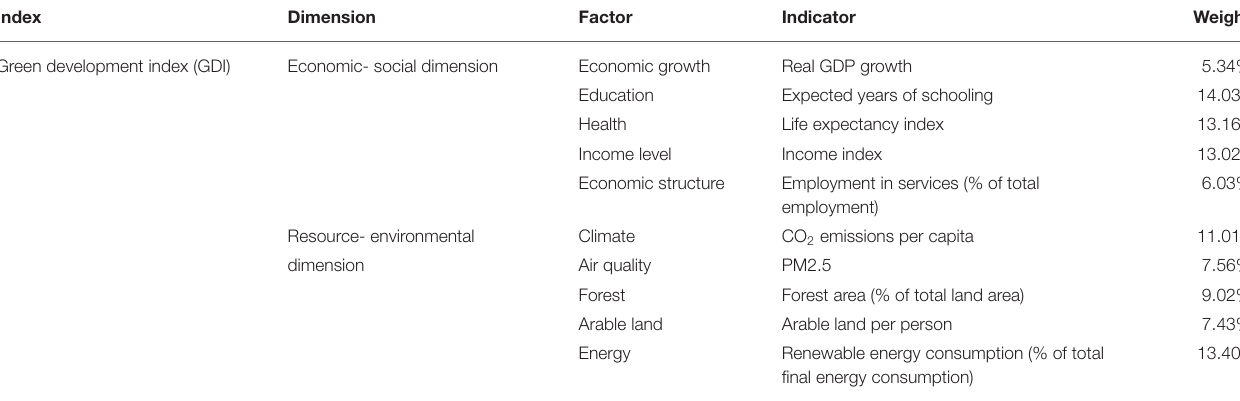
TABLE 2 | The weight of each indicator in green development index.